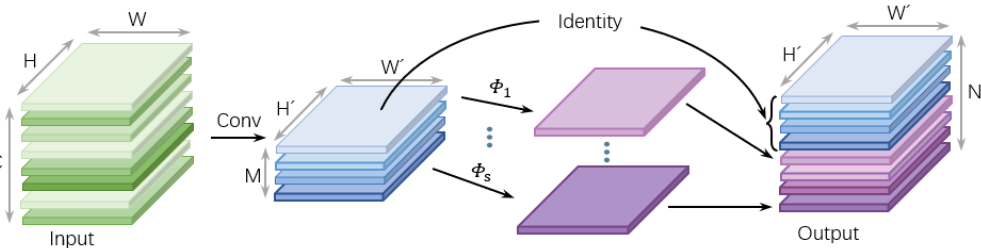
Figure 4. Ghost module . Φ represents the cheap operation.